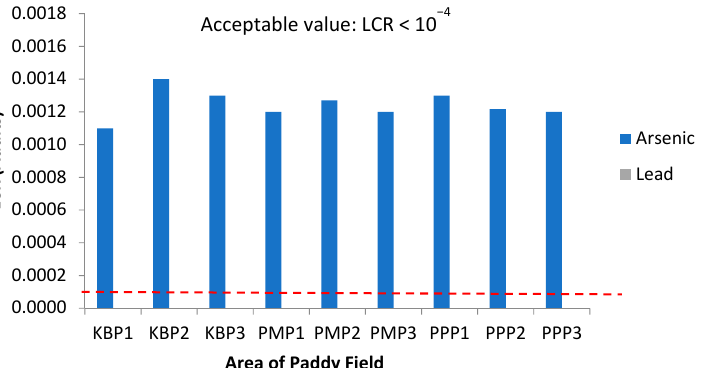
Figure 10. Lifetime cancer risk (LCR) values for adults via intake of rice from the different sampling sites in Kelantan. KBP1: Kota Bharu Plot 1, KBP2: Kota Bharu Plot 2, KBP3: Kota Bharu Plot 3, PMP1: Pasir Mas Plot 1, PMP2: Pasir Mas Plot 2, PMP3: Pasir Mas Plot 3, PPP1: Pasir Puteh Plot 1, PPP2: Pasir Puteh Plot 2, and PPP3: Pasir Puteh Plot 3.